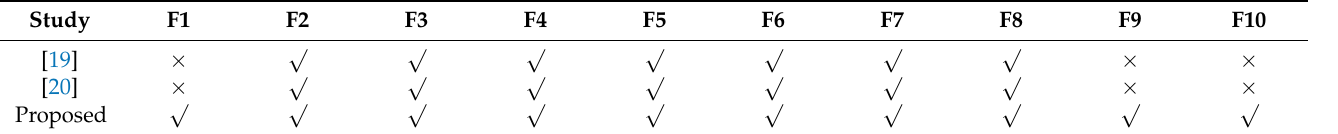
Table 4. Comparison based on informal security features between proposed and existing